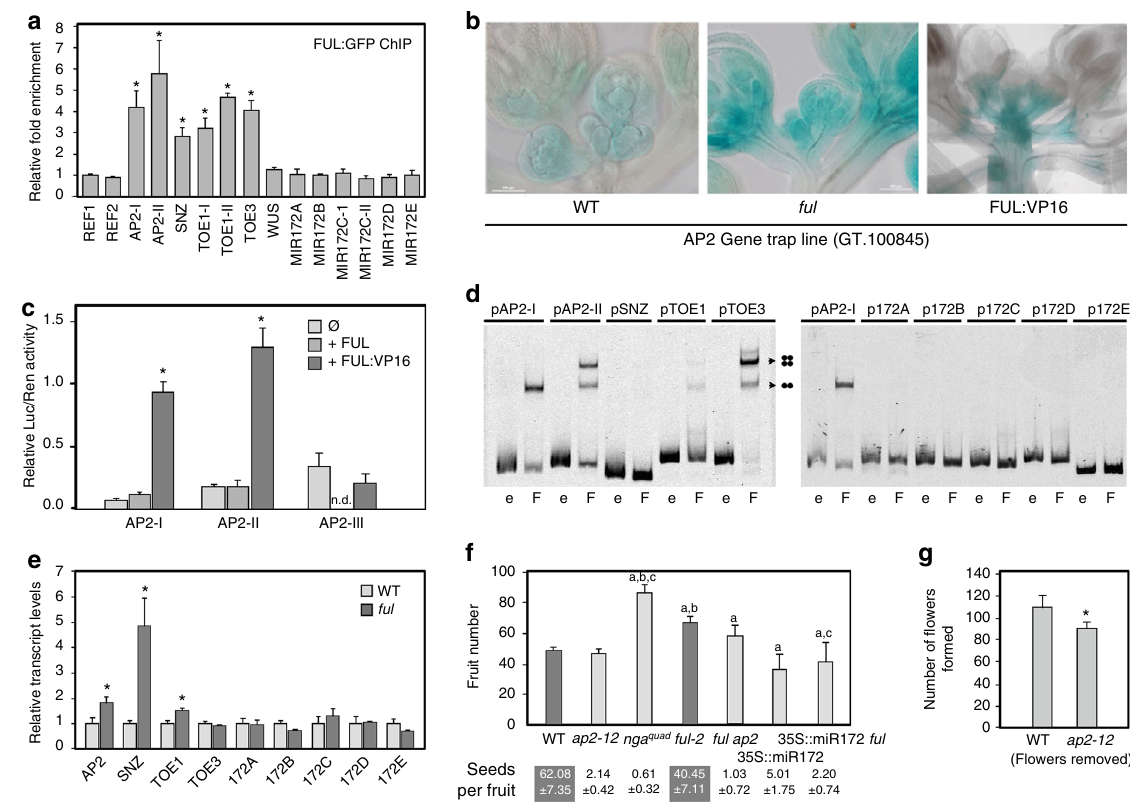
Fig. 4 AP2 and AP2 -like genes control GPA timing. a ChIP-qPCR experiment showing the enrichment of the different fragments relative to REF1 in ChIP samples from IM tissue of ap1 cal pFUL::FUL:GFP plants. Fragment enrichment was calculated as a percentage of the corresponding input sample. See Supplementary Data 1 for information about the fragments. Enrichment is detected for AP2 , SNZ , TOE1 and TOE3 , but not for WUS and the MIR172 genes. b In the gene trap line GT.100845, the activity of a miR-independent GUS reporter inserted in the 5 ’ -UTR of the AP2 gene is elevated both in ful and FUL:VP16 backgrounds. All panels correspond to heterozygotes AP2 (WT)/AP2-GT.100845. c Luciferase reporter assay in N . benthamiana leaves co-transformed with 35S::FUL or 35S::FUL:VP16 and different reporter lines where the AP2 promoter fragments enriched in FUL ChIP-seq results (AP2-I and AP2-II) and other non-enriched fragment (AP2-III) drive the expression of the Luc gene. Ren expression is used as internal control and Luc/Ren ratios are represented. d Binding of FUL to different DNA probes in an EMSA assay (as indicated on top of the lanes). The absence or presence of FUL (e, empty or F, FUL) is indicated at the bottom. The AP2-I fragment was loaded on both gels. The arrows indicate the shifts that can be attributed to binding of a FUL homodimer or a FUL homotetramer. More information about the probes can be found in Supplementary Data 1. e Transcript levels of AP2-like genes bound by FUL in in fl orescence apices of wild-type and ful mutants: AP2 , SNZ and TOE1 are signi fi cantly overexpressed in ful , while transcript levels of MIR172 genes are not affected. f ap2-12 mutants produce a similar number of fl owers than WT in spite of severely reduced fertility (noted by seed number per fruit), but much less than the unrelated sterile nga quad mutant; 35S::miR172 plants, where expression of AP2 and related genes is reduced, show further reduced fl ower production. The delayed GPA observed in ful mutants is not fully suppressed by the ap2-12 mutation, but almost completely in the 35S::miR172 background. Shaded bars and shaded boxes in seed numbers indicate genotypes where fertility is above the threshold affecting GPA timing. Superscript letters indicate a signi fi cant difference ( P < 0.001) from Col ( a ), ap2-12 ( b ) and ful-2 ( c ) controls, respectively, according to t test. g Induced sterility by continuous pruning of developing fl owers causes increased fl ower production in WT and ap2-2 mutants. Error bars represent the SE of four biological replicas in the case of expression analyses, three replicas for the ChIP-qPCR and six replicas for the Luc assays. Signi fi cant differences from the control ( t test, P < 0.05) are indicated with an asterisk in a , c , e , g ). n = 10 for all genotypes in f ,